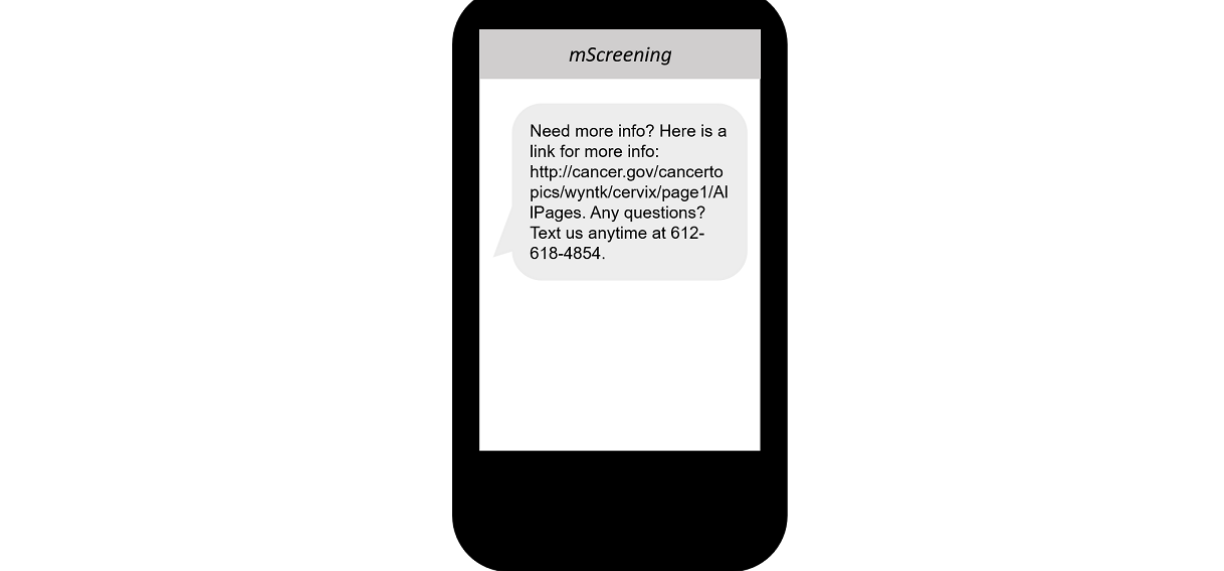
Figure 11. Mobile screening message example: provided one message that contained an online link for further